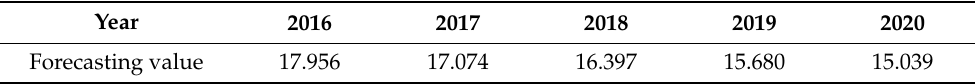
Table 4. Forecast of China’s sulfur dioxide emissions (unit, million